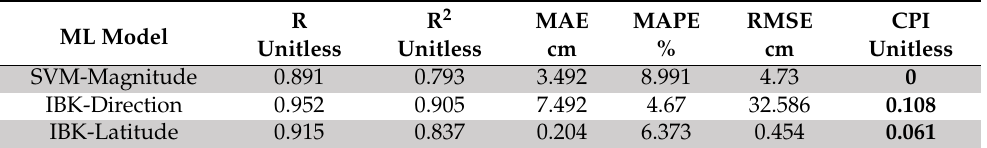
Figure 6. Best results of the predicted data points (25% database) versus the measured data points (75% database) on the ( a ) impact magnitude, ( b ) direction and ( c ) latitude, using four ML models that include: (1) support vector machine (SVM), (2) multilayer perceptron—artificial neural network (MLP-ANN), (3) random forest (RF), and (4) IBK. The plotted data represent 25% of the parent database that was not previously included in the training process of the ML models. The dashed line represents the line of ideality, and the solid lines represent the ±10% boundaries. Table 1. Selected best prediction performance ML models on impact magnitude, direction and latitude, respectively. Five statistical parameters (i.e., R, R 2 , MAE, MAPE, and RMSE) and the composite performance index (CPI) are shown.